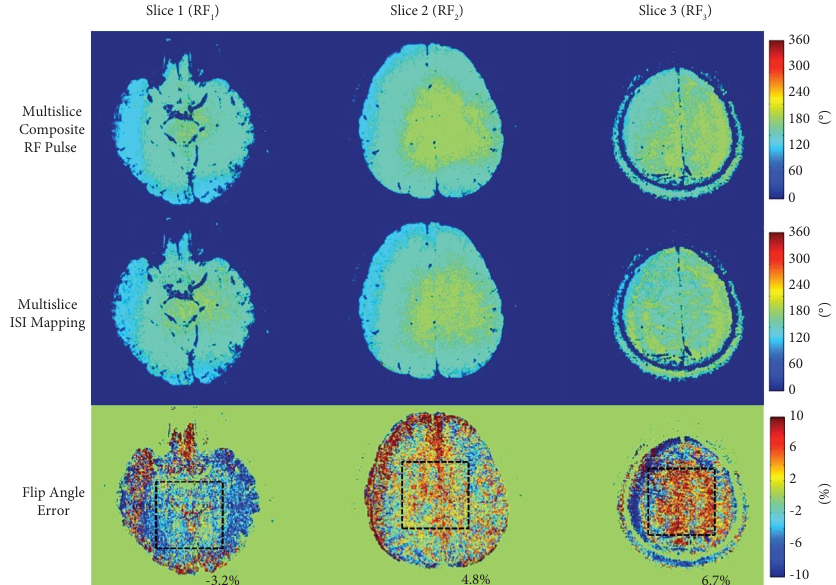
Figure 7: FA maps of the proposed B 1 mapping method and multislice ISI mapping method for an in vivo human brain and FA error maps for three echo signals (RF 1 , RF 2 , and RF 3